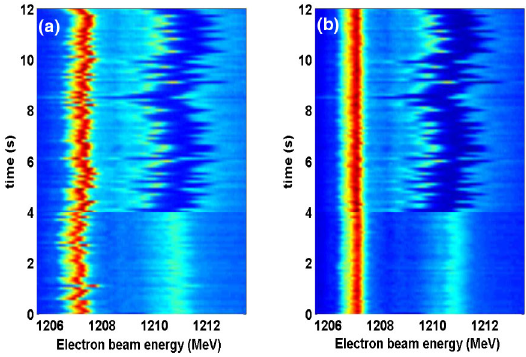
FIG. 4 (color online). (a) Sequence of the electron-beam spectra acquired in MBD. Spectra for time < 4 s refer to electron beam that have not been interacting with the seed laser. Spectra for seeded beams ( t > 4 s) clearly show that in addition to the fluctuation in mean energy of the beam also the hole induced by the seed is fluctuating around 1211 MeV. Panel (b) shows the same data corrected for energy